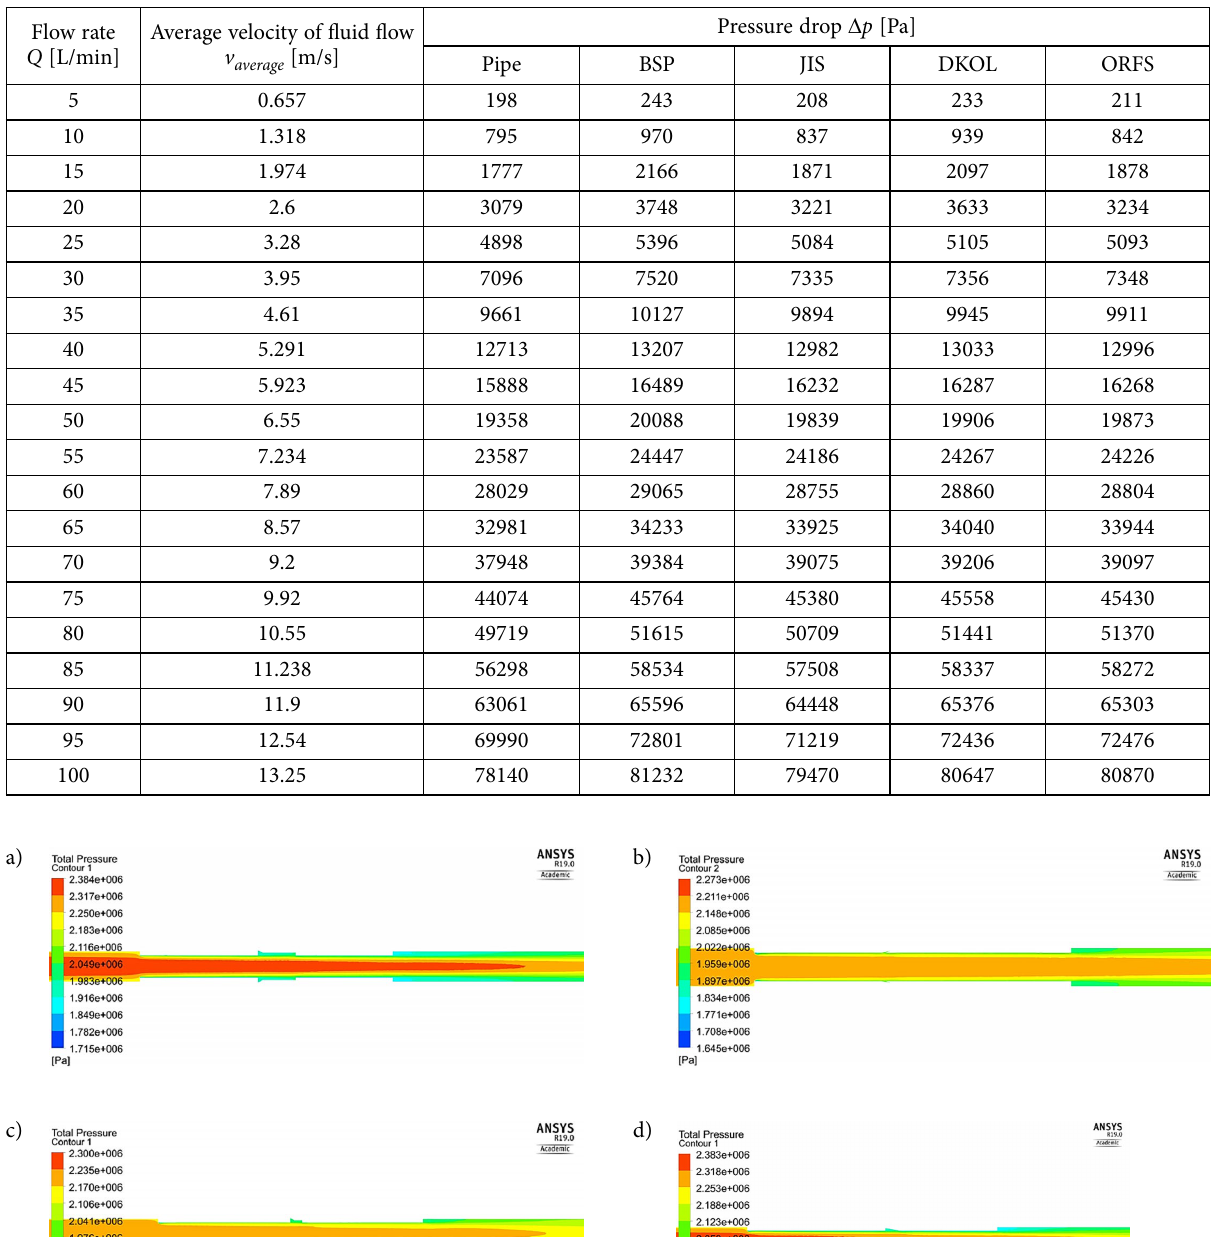
Table 6. The results of fluent simulation (pressure drop)